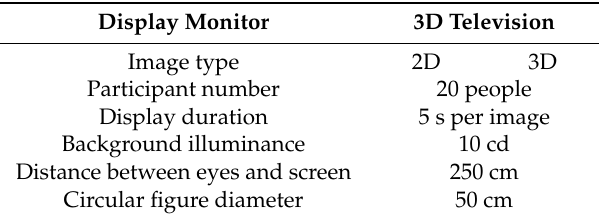
Table 1. Experimental